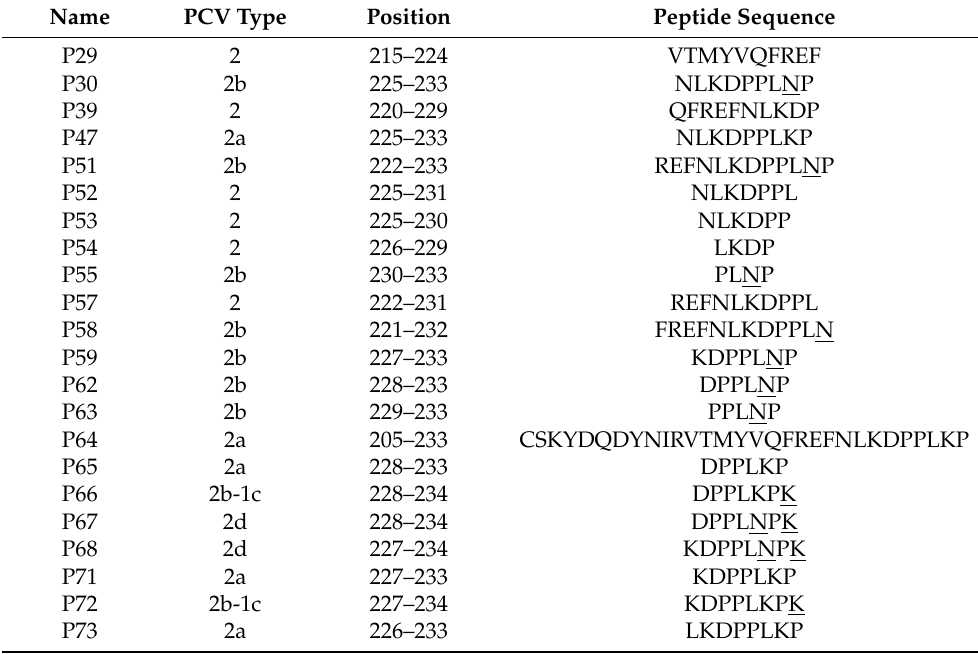
Table 1. Peptide sequences of the truncated carboxyl-terminus (C-terminus) of the capsid protein of